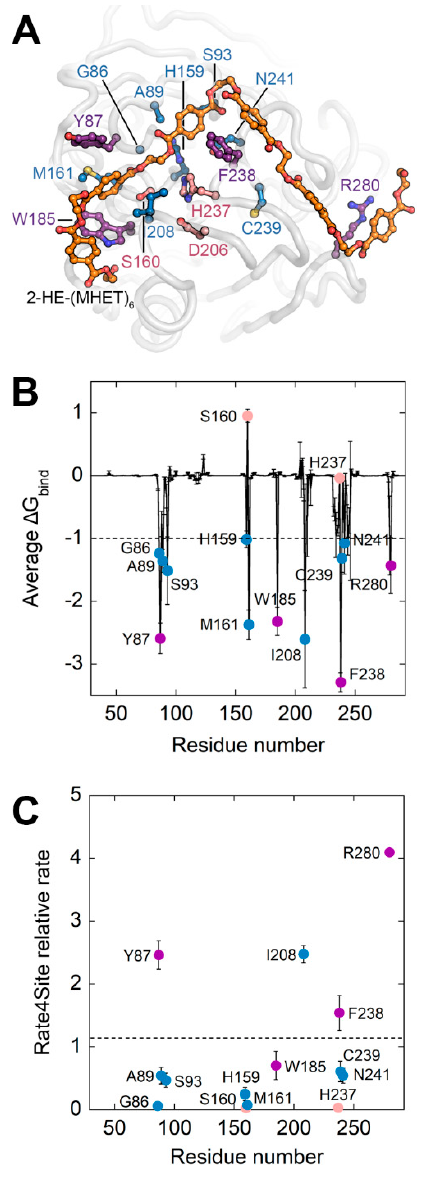
Figure 2. Computational analysis of the interaction between ∆ IsPET and 2-HE-(MHET) 6 . ( A ) ∆ IsPET:2-HE-(MHET) 6 complex. Representative frame of the MD simulation of the ∆ IsPET:2-HE-(MHET) 6 complex possessing the minimum estimated ∆ G bind . The ligand 2-HE-(MHET) 6 is represented as sticks and colored according to atom type (carbon in gray and oxygen in red): the carbon of the ester bond of the substrate which undergoes the nucleophilic attack is indicated by a black circle. Protein residues are visualized as balls and sticks; residues whose average contribution to ∆ G bind is ≤− 1 kcal mol − 1 are depicted in blue or purple, if excluded or considered for SSM, respectively. Ser160 has a positive ∆ G bind because it was harmonically constrained to the attacked carbonyl of the docked ligand. Residues forming the catalytic triad are depicted in pink. ( B ) Plot of average and standard deviation of estimated per-residue ∆ G bind . The dashed bar represents the Δ G bind threshold of -1 kcal mol − 1 used to predict hot-spot residues interacting with 2-HE-(MHET) 6 . (C) Plot of average Rate4Site conservation scores for Δ IsPET residues whose binding contribution is ≤ -1.0 kcal mol − 1 . The dashed bar represents the average conservation rate of the whole sequence (= 1.2). Symbols in panel ( B , C ) are colored accordingly to the color scheme of panel ( A ).